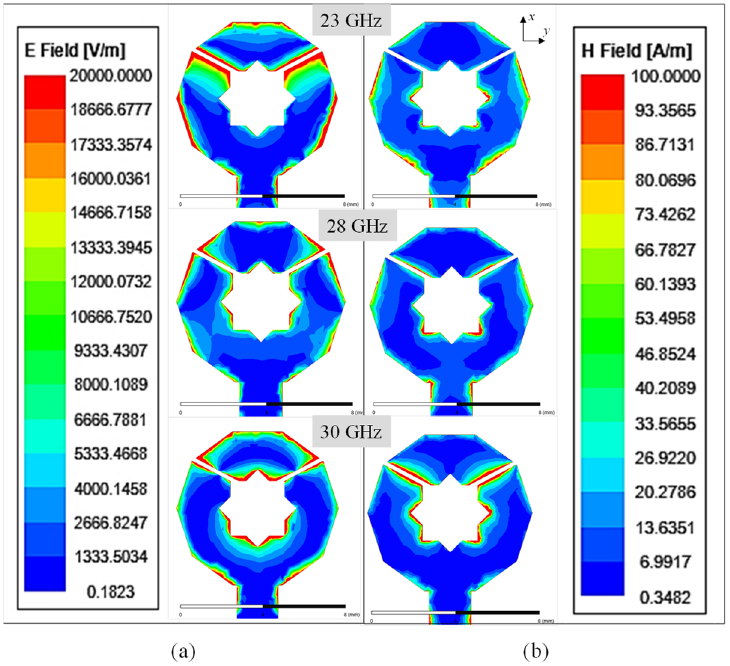
Figure 5. ( a ) Electric field ( b ) magnetic field (in magnitude) plotted in the upper layer of the metal at 23 GHz, 28 GHz, and 30 GHz.